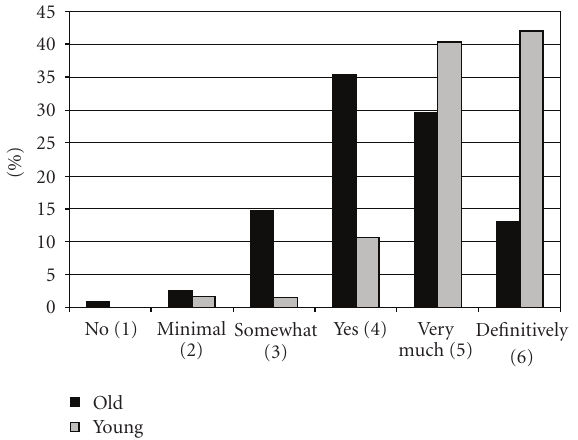
Figure 1: Global rating on treatment necessity.